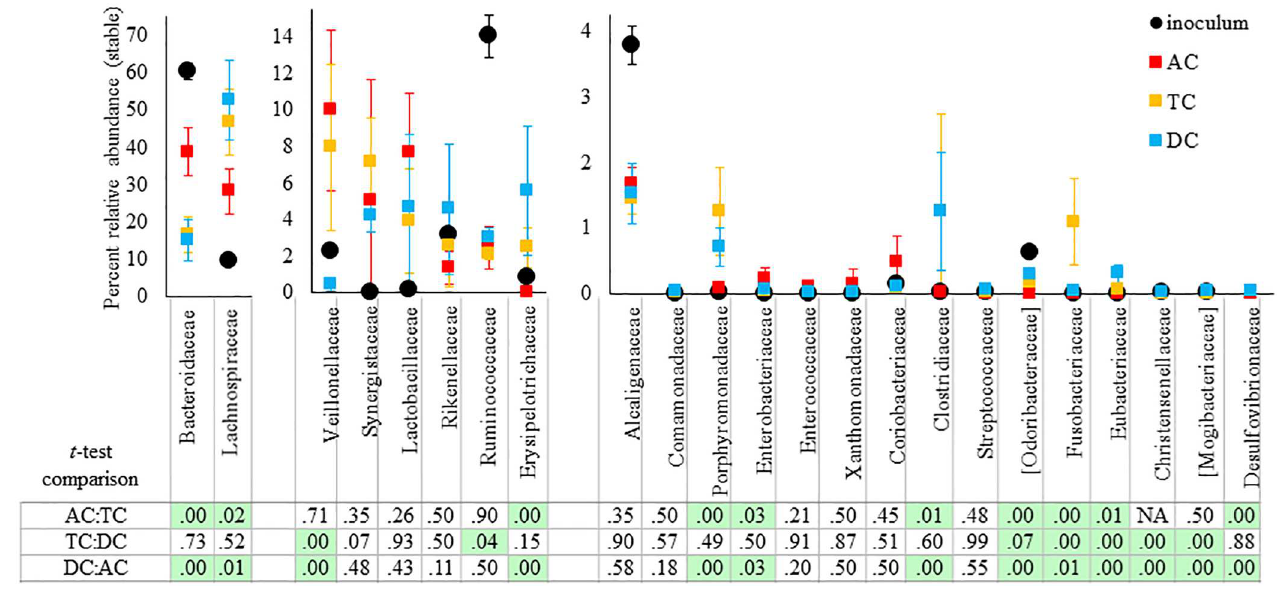
Fig 5. Comparison of relative abundance at the family level between the mucosal phase of the AC, TC, and DC regions of the SHIME 1 system. The relative abundance at the family level for each region at each all time points after stabilization (Day10-Day 43) were averaged and plotted together. Only families with at least a .01% relative abundance in at least one region were considered. The error bars represent the standard deviation between the percent abundance at these time points. The P values based on a 2 tailed student t- test between regions are listed in the bottom chart. P values were corrected for multiple comparison. A green box indicates that the p value was less than 0.05.